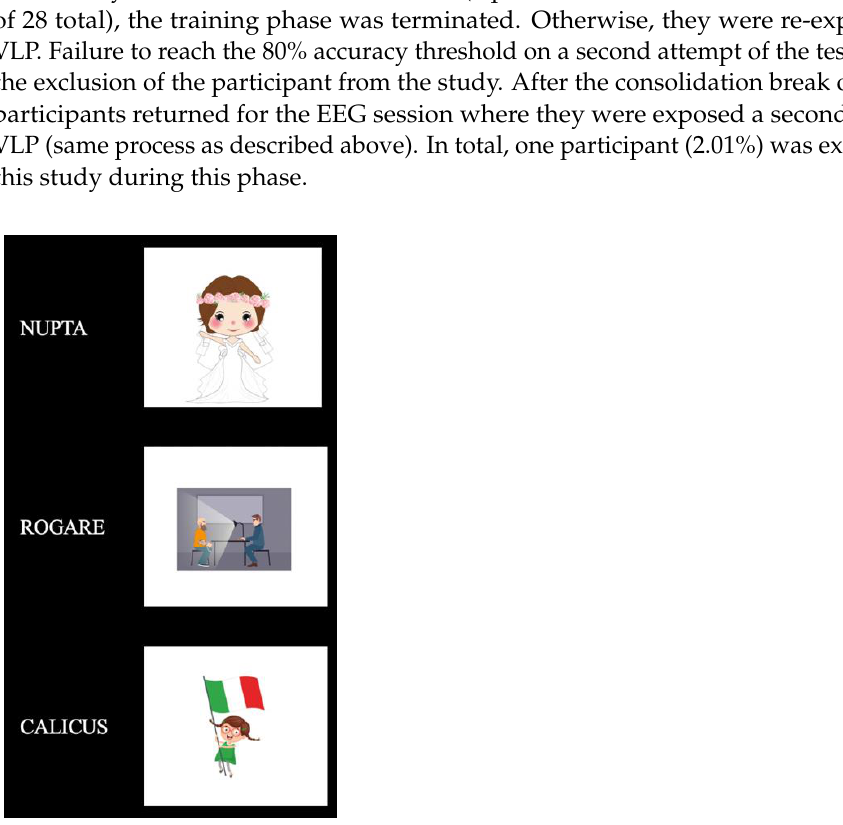
rogat ludi-am calic-am the.bride- NOM . F interrogates the.dancer- ACC . F Italian- ACC . F ‘The bride interrogates the Italian dancer.’ Thus, this phase introduced both nominative and accusative case morphology (criti- cal item ludiam in (8)) and adjective position ( calicam ). Exposure to case morphology and adjectival position was achieved through the presentation of 128 meaningful sentences in Mini-Latin without explicit teaching/explanations. These sentences resulted from the crossing of the 28 lexical items of Mini-Latin. The sentences appeared together with 4 se- ries of pictures, where each series was composed of 4 figures. Only one series of pictures depicted the correct lexical order of the sentence. The other 3 were composed so that the